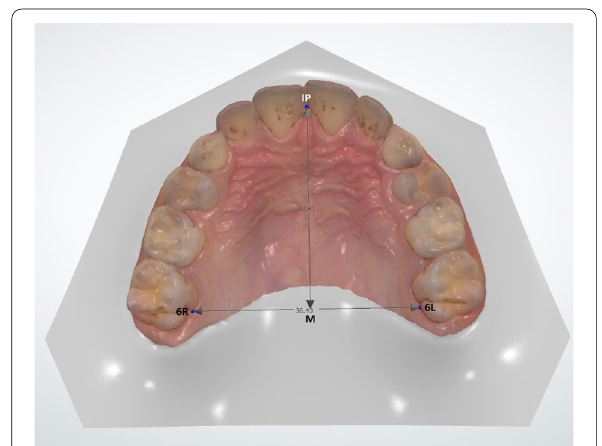
Fig. 1 Measuring of the lengths of 3R-3L, 4R-4L, 5R-5L, and 6R-6L on a 3D digital model